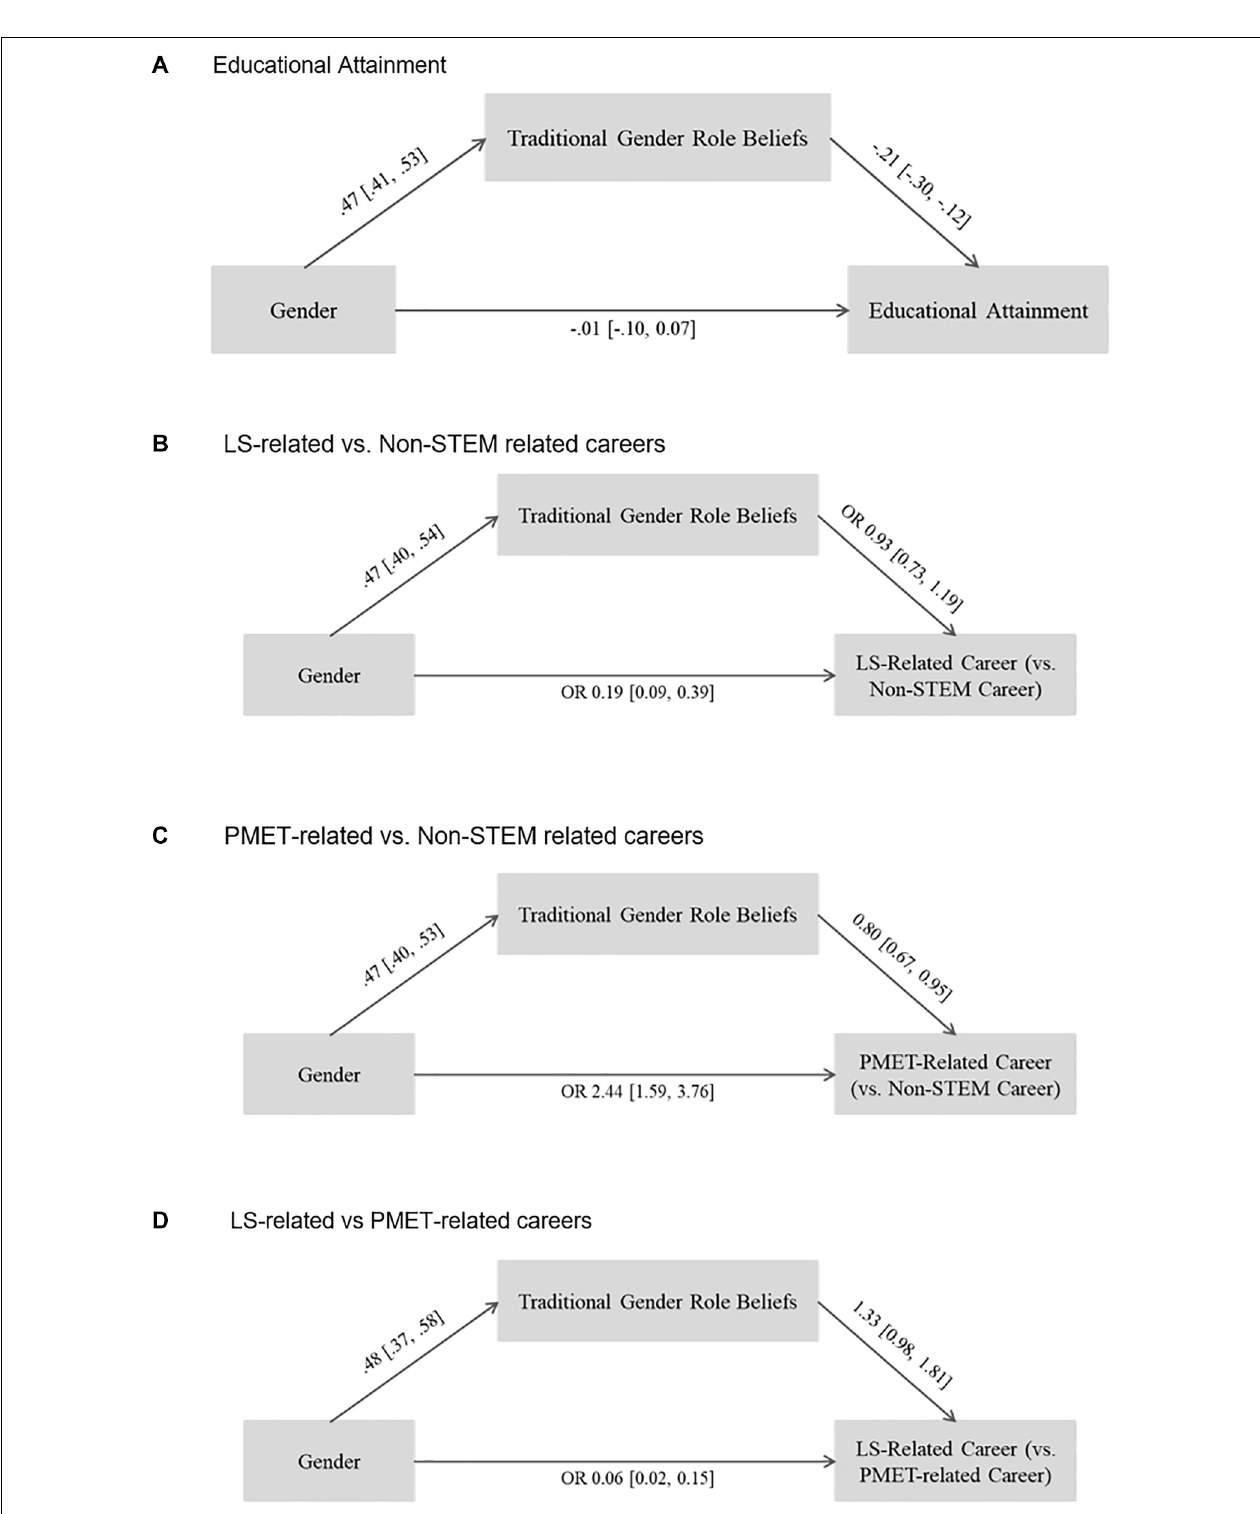
FIGURE 5 | Results of path analyses investigating the mediation of the association of gender with educational and STEM occupational attainment outcomes via traditional gender role beliefs. Gender coded 1, male. (A) Results for educational attainment, (B) results for comparison of LS-related vs. non-STEM related careers, (C) results for comparison fo PMET-related vs. non-STEM related careers, and (D) results for comparison of LS-related vs. PMET-related careers. Standardized coefficients are shown for continuous variables. OR, Odds Ratio. 95% Confidence intervals in brackets. Confidence intervals excluding 0/1 for regression coefficients/odds ratios indicate statistical